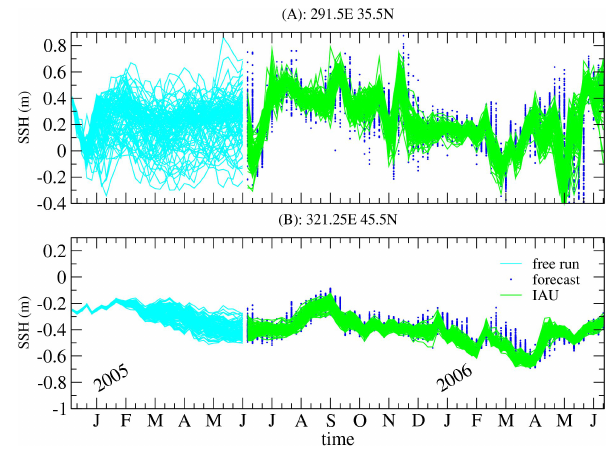
Figure 6. SSH time series of the ensemble (free run, forecast and IAU) at locations (a) and (b)